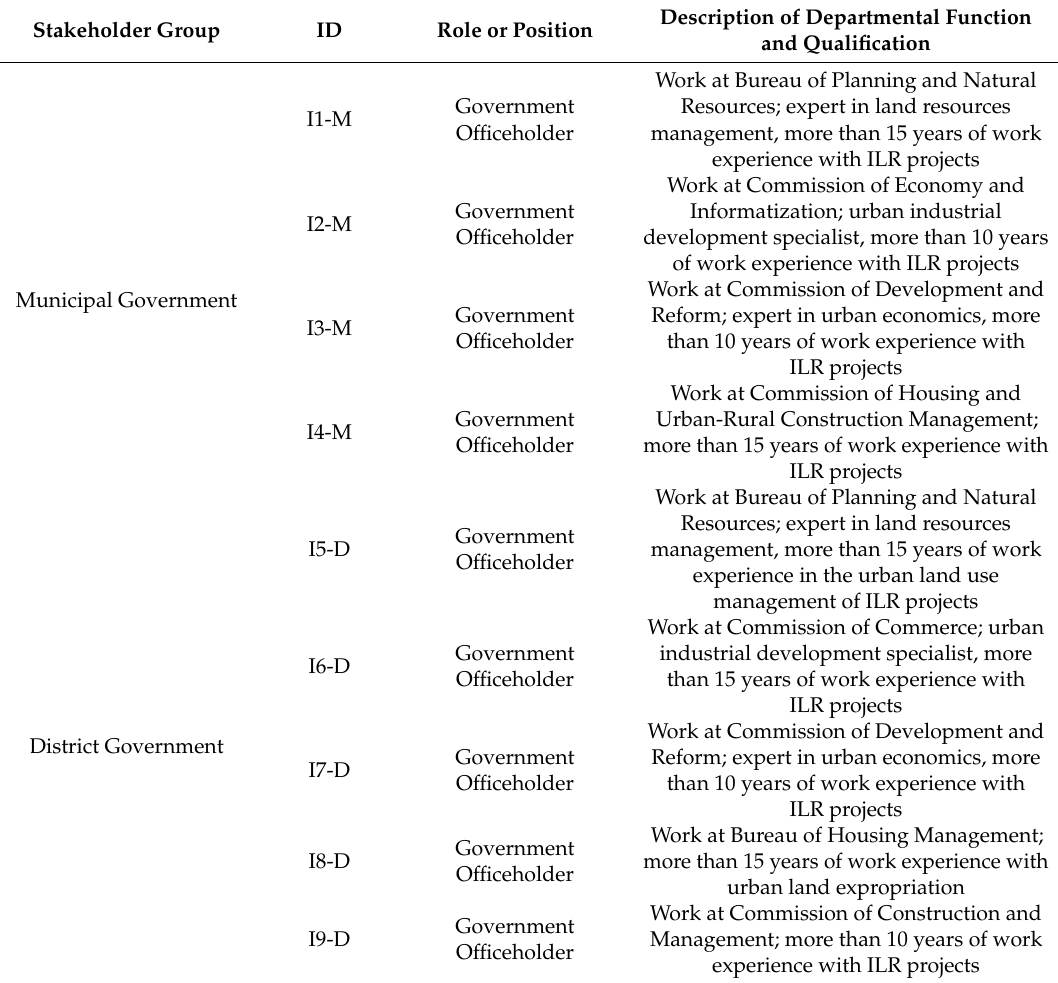
Table 1. Detailed background description of the